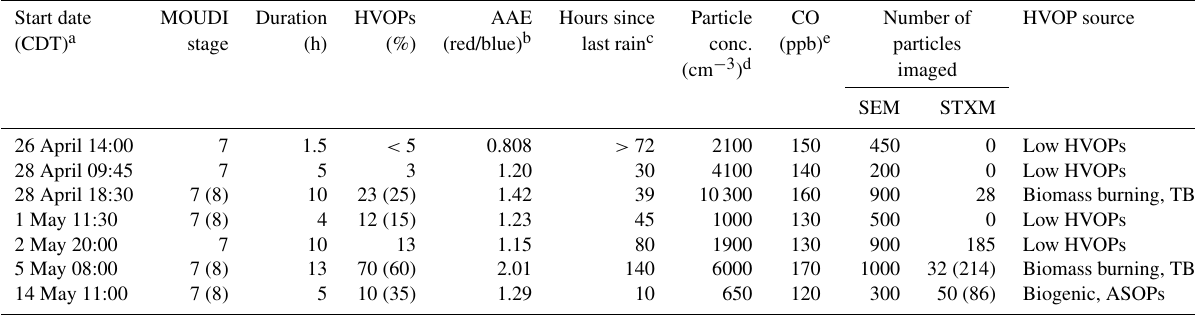
Table 1. Ambient sampling information. Stage 8 values in parentheses when available.